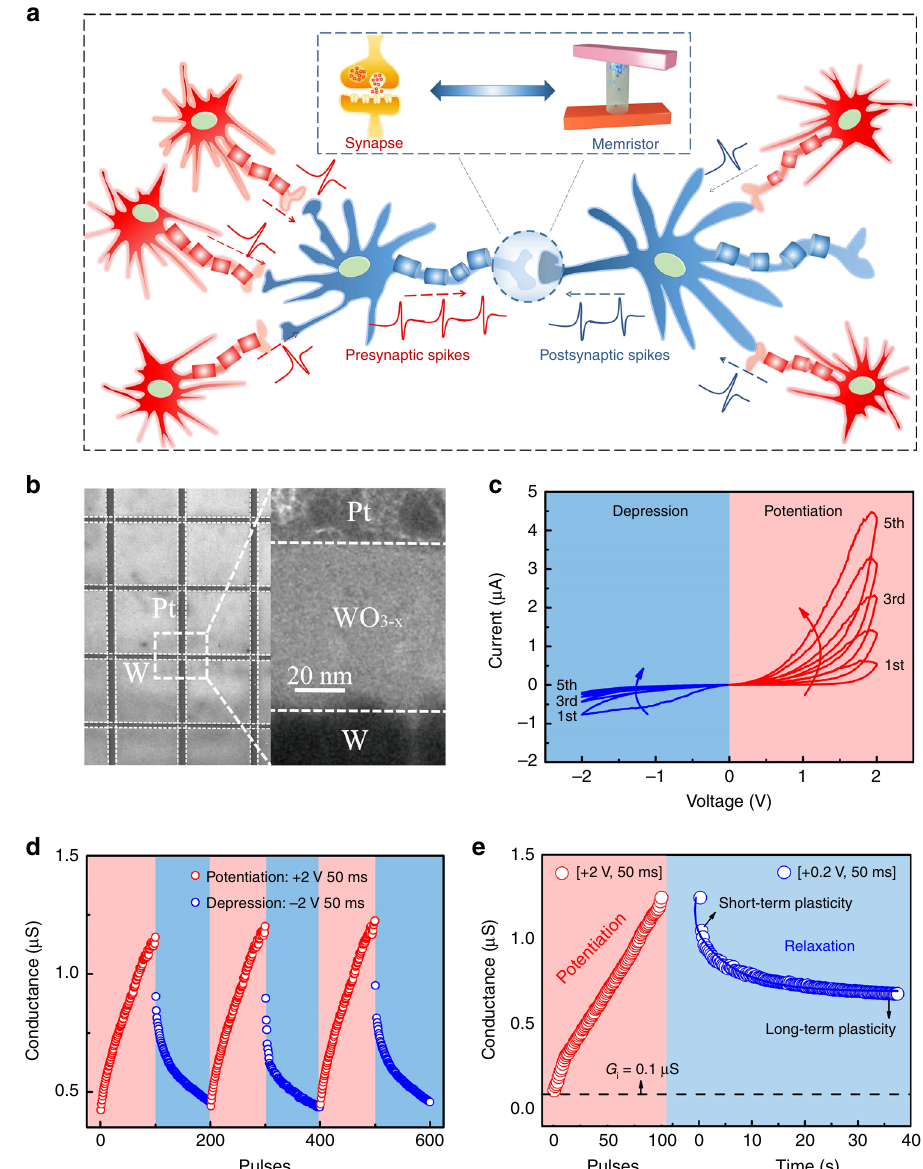
Fig. 1 Arti fi cial synapse based on the WO 3 − x second-order memristor. a Schematic of spike trains in a biologic system, produced by a neuron receiving multiple spikes from other connected neurons. b Scanning electron microscopy image of the memristor crossbar array and a transmission electron microscopy image of the cross-section of the Pt/WO 3 − x /W memristor. c I – V curve of the memristor under a continuous positive sweep (0 to 2 V) and negative sweep (0 to − 2 V). d Potentiation and depression of conductance G c caused by the repeated stimulation of 100 positive pulses [ + 2 V, 50 ms] and 100 negative pulses [ − 2 V, 50 ms]. All the data of G c were collected 1 s after the stimulation using a reading pulse [ + 0.2 V, 50 ms], which represents the long-term plasticity. e Spontaneous decay of conductance G c after the potentiation process. This decay process may be related to the diffusion of oxygen ions, which is an indicator of a second-order memristor. Here, the device was operated from an initial conductance G i of 0.1 µ S. The relaxation process was monitored under a read pulse [ + 0.2 V, 50 under a single presynaptic spike [2 V, 10 ms]. The fi gure shows capacitance, which is discussed in a recent paper by Yang et al. 50 . that the presynaptic spike triggers an abrupt increase in current In a biological system, the Ca 2 + dynamics allow correlation followed by a decay to the initial state within 400 ms, which is between paired spikes, where the residual Ca 2 + induced by the fi rst spike enhances the overall Ca 2 + concentration generated by similar to the behavior of the excitatory postsynaptic current (EPSC) of the biological synapse 21,24 . The similarity with the the second spike, thus resulting in PPF. The PPF function is biological EPSC behavior is caused by oxygen-ion drift and dif- critical for a synapse to make correlations between the temporal fusion in our memristor paralleling the in fl ux and extrusion of spike pair. Based on the similarity between oxygen-ion dynamics Ca 2 + through the synaptic cell 24,49 . It is noted in Fig. 2a that and Ca 2 + dynamics, we can demonstrate PPF, as shown in there is not an abrupt decrease in current observed, when the Fig. 2b. When the second stimulation comes before the fi rst EPSC stimulation pulse of 2 V is changed to the monitoring pulse of 0.2 disappears completely, their overlap can effectively suppress the V. One of the possible reasons is the electric double-layer (EDL) diffusion of oxygen ions. This promotes the more effective